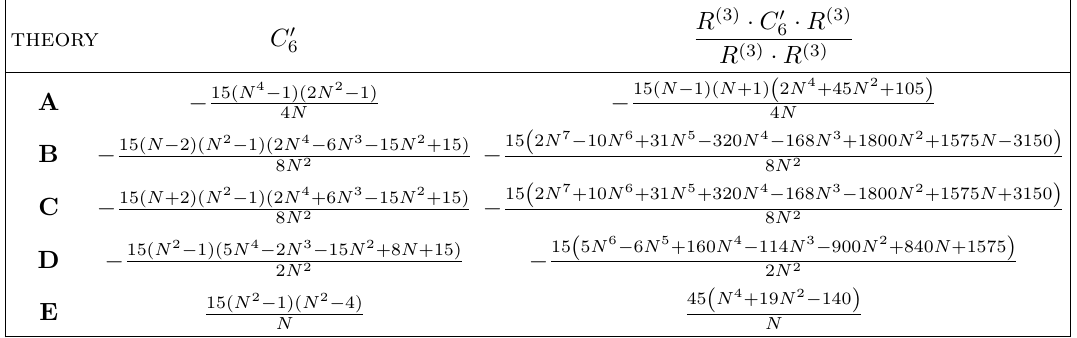
Table 3 . Theory dependent coe(cid:14)cients determining the three loop (cid:16) (5) contribution to the scaling functions F ((cid:1)) for the two towers with (cid:1) = 2 ;